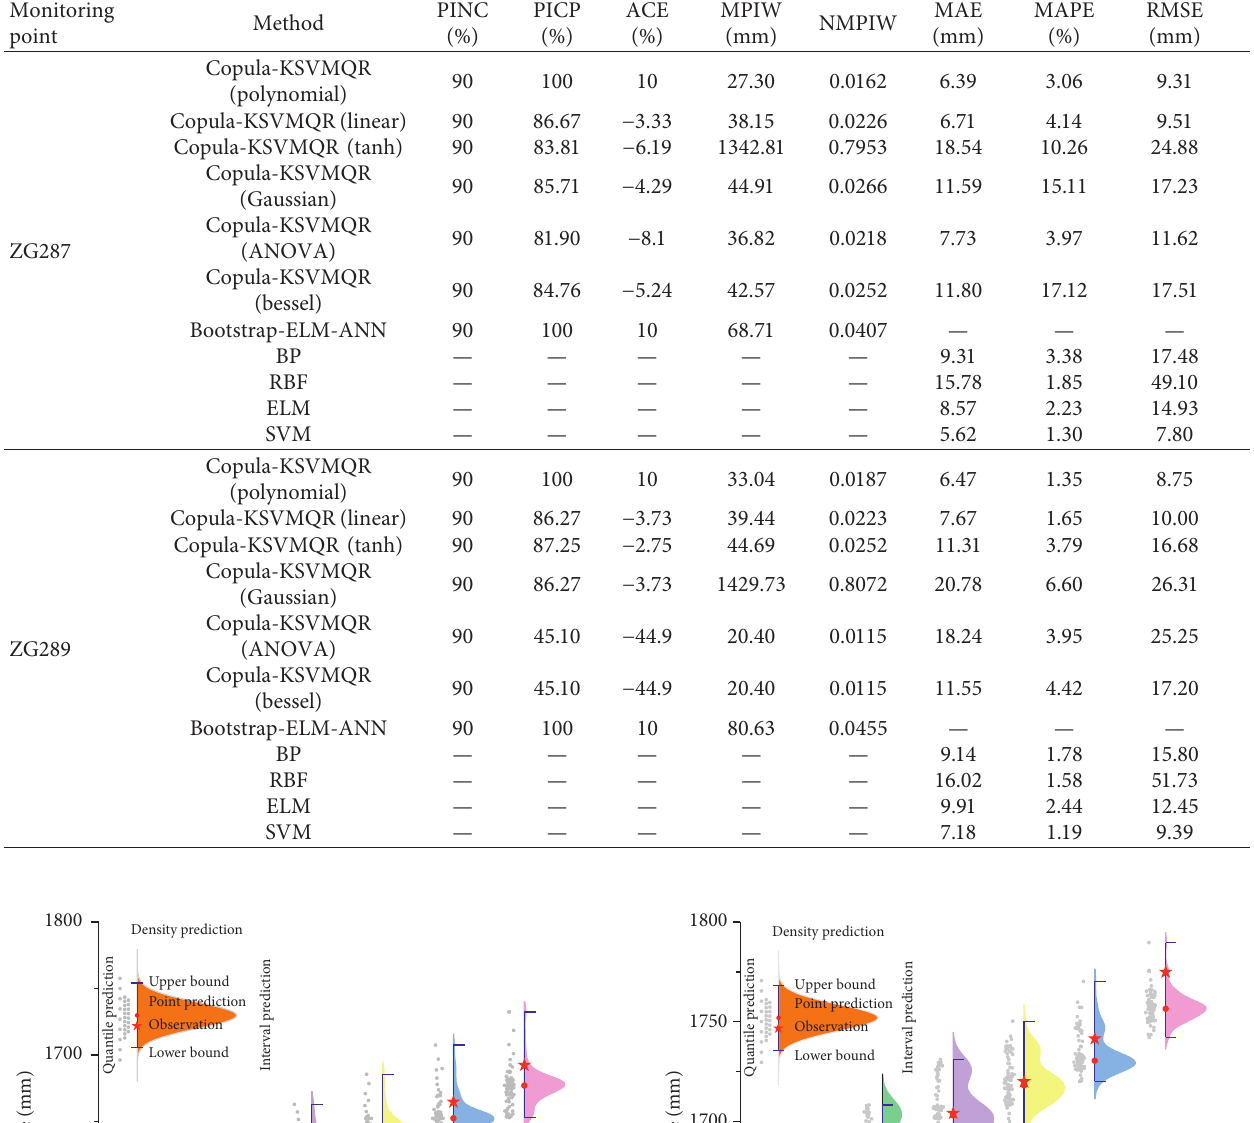
Table 5: Performance indices for the predictions of the Tanjiahe landslide.